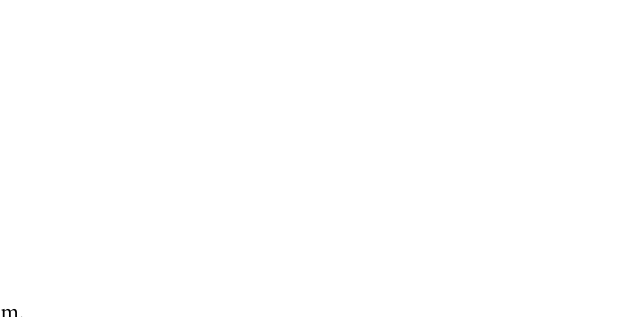
Table 2. Parameters of flexible